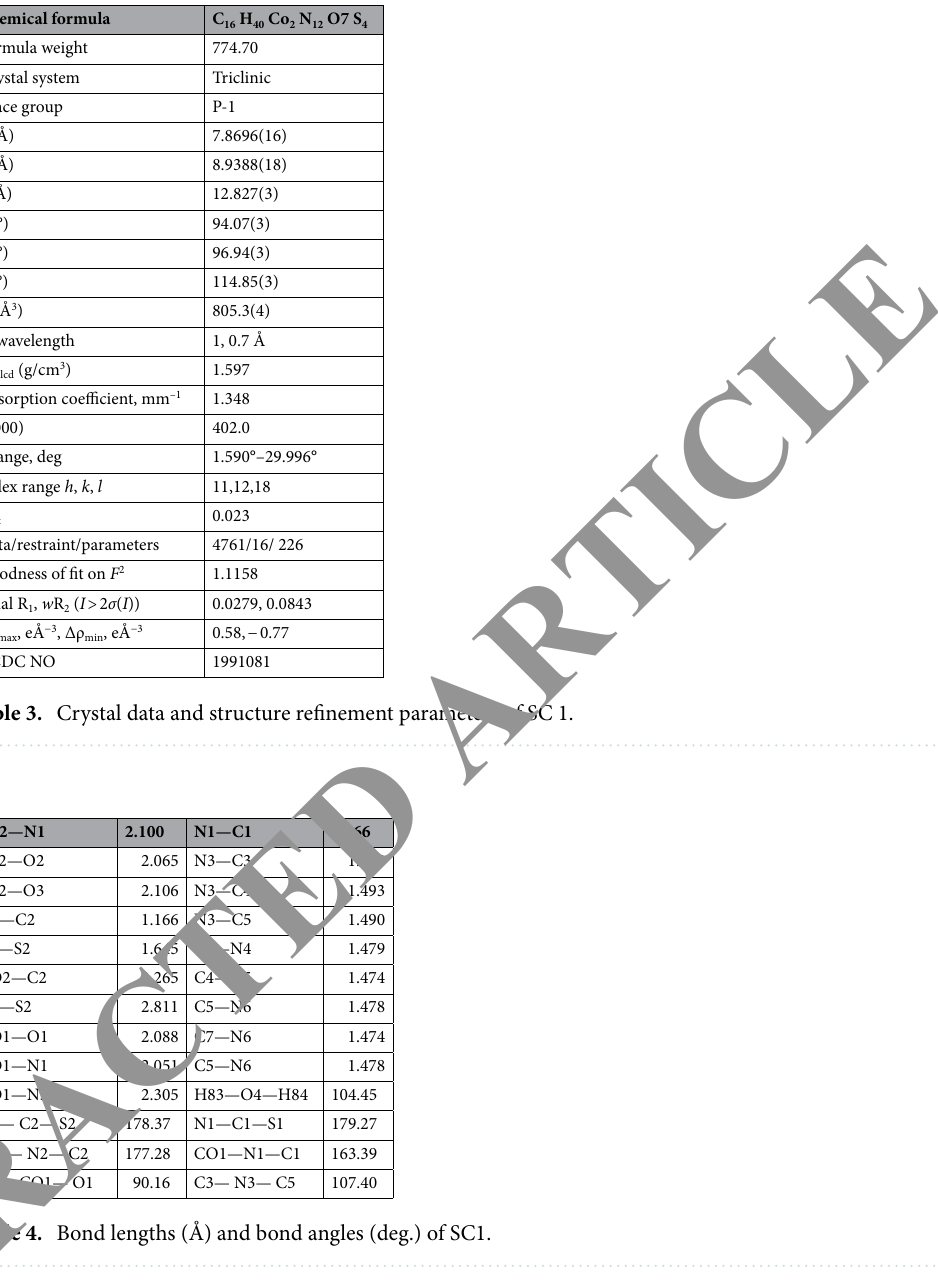
Table 4. Bond lengths (Å) and bond angles (deg.) of